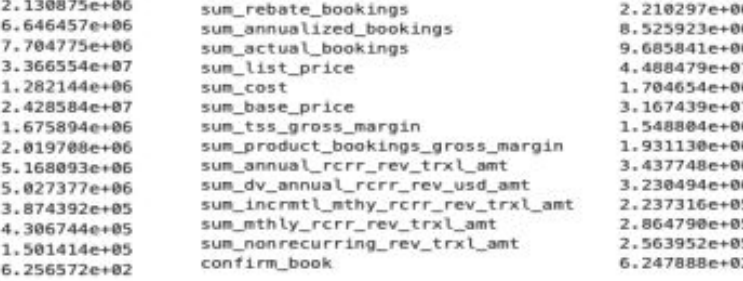
Figure 6. Comparison of the two types of